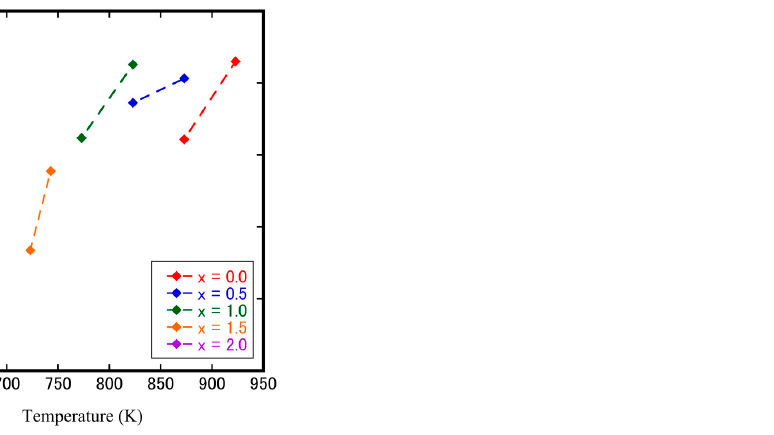
Figure 7. Relative densities of ZrW 2 − x Mo x O 8 bulk ceramics sintered at various sintering temperature.